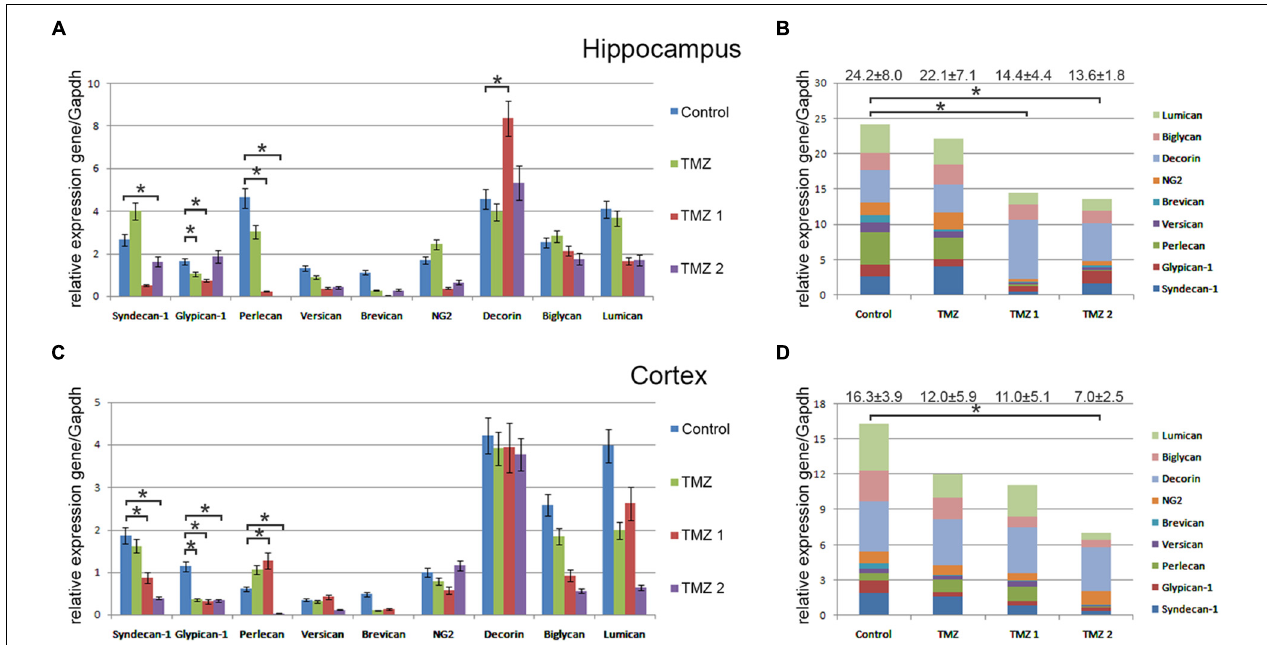
FIGURE 4 | Proteoglycan expression levels in hippocampus and cortex of 2-month Wistar rats before and after treatments with different TMZ-based drugs. (A,B) Hippocampus, (C,D) Cortex. (A,C) mRNA expression levels of individual proteoglycan genes. RT-PCR analysis, intensity of the amplified DNA fragments normalised to that of Gapdh , bars represent the mean ± SD from triplicate experiments, Student’s t -test (OriginPro 8.1). (B,D) Overall transcriptional activity of PG core proteins in different TMZ-treated groups of animals. Stacked column compares the contribution of each value to a total across categories. Proteoglycan mRNA expression levels in hippocampus and cortex of 2-month Wistar rats before and after treatments with DXM and/or TMZ. mRNA expression levels of individual proteoglycan genes in hippocampus (A) and cortex (C) . Overall transcriptional activity of the total pool of all studied PGs in hippocampus (B) and cortex (D) . Expression pattern of the individual PG core protein-coding gene as percentage of 100%. RT-PCR analysis, intensity of the amplified DNA fragments normalised to that of Gapdh . Bars represent the mean ± SD from triplicate experiments (OriginPro 8.0). ∗ p <